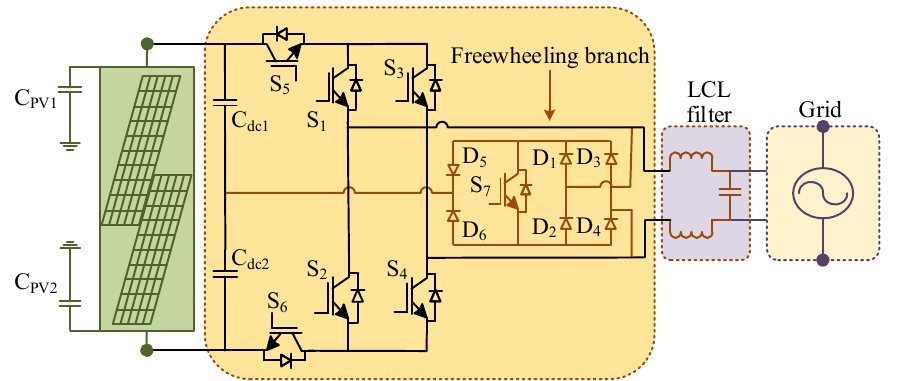
Figure 2. Schematic diagram of proposed inverter topology.